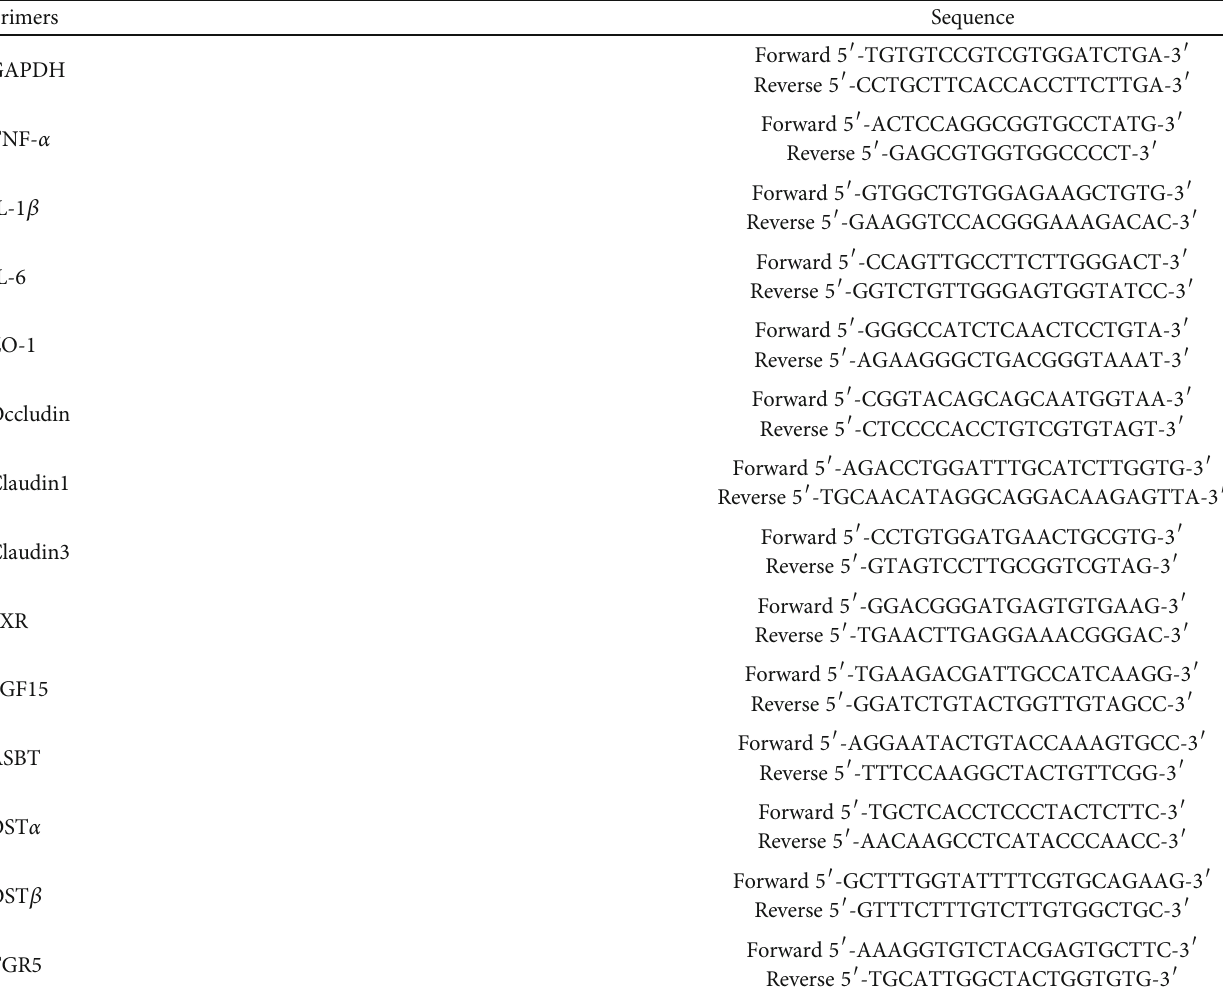
Table 1: The oligonucleotide primer sequences used in the